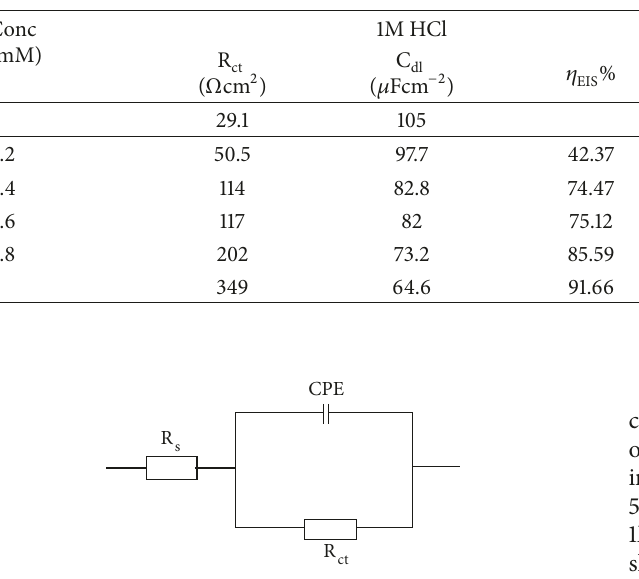
Figure 10: Randles circuit used for EIS